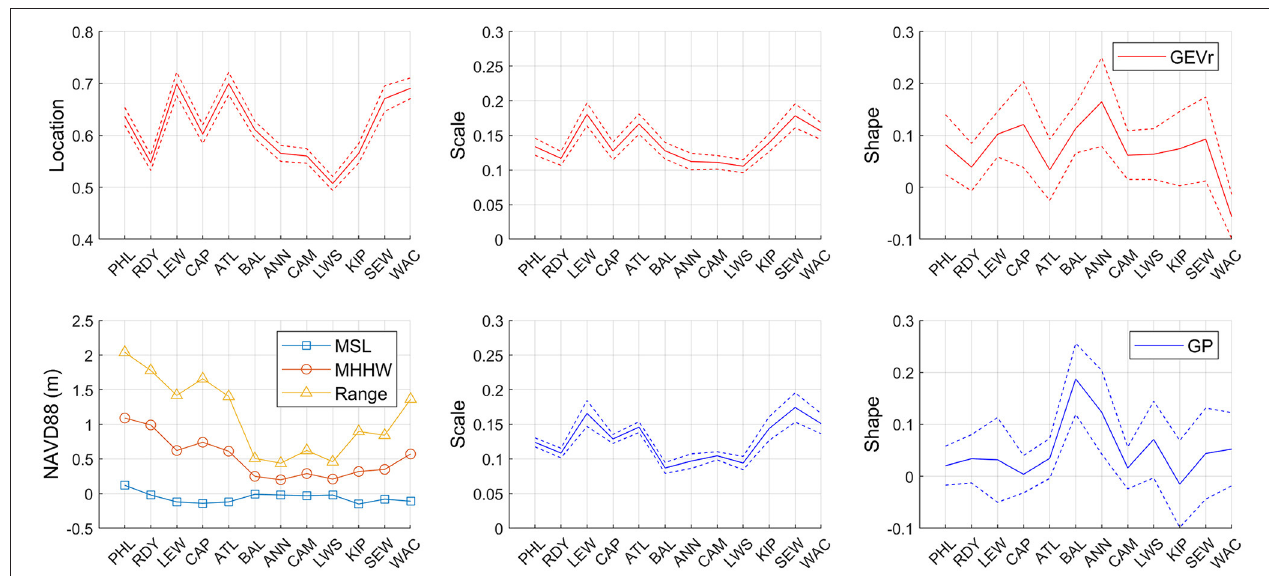
FIGURE 4 | Model fit parameters of extreme skew surges to the GEVr (red, top row) and GP (blue, bottom row) distributions. Location is a model parameter only for GEVr distribution. Dotted lines represent the 90% confidence interval. Mean Sea Level (MSL), Mean Higher-High Water (MHHW), and Great Diurnal Range (GT) tidal datums defined by NOAA for the current National Tidal Datum Epoch 1983–2001 referenced to NAVD88 meters.